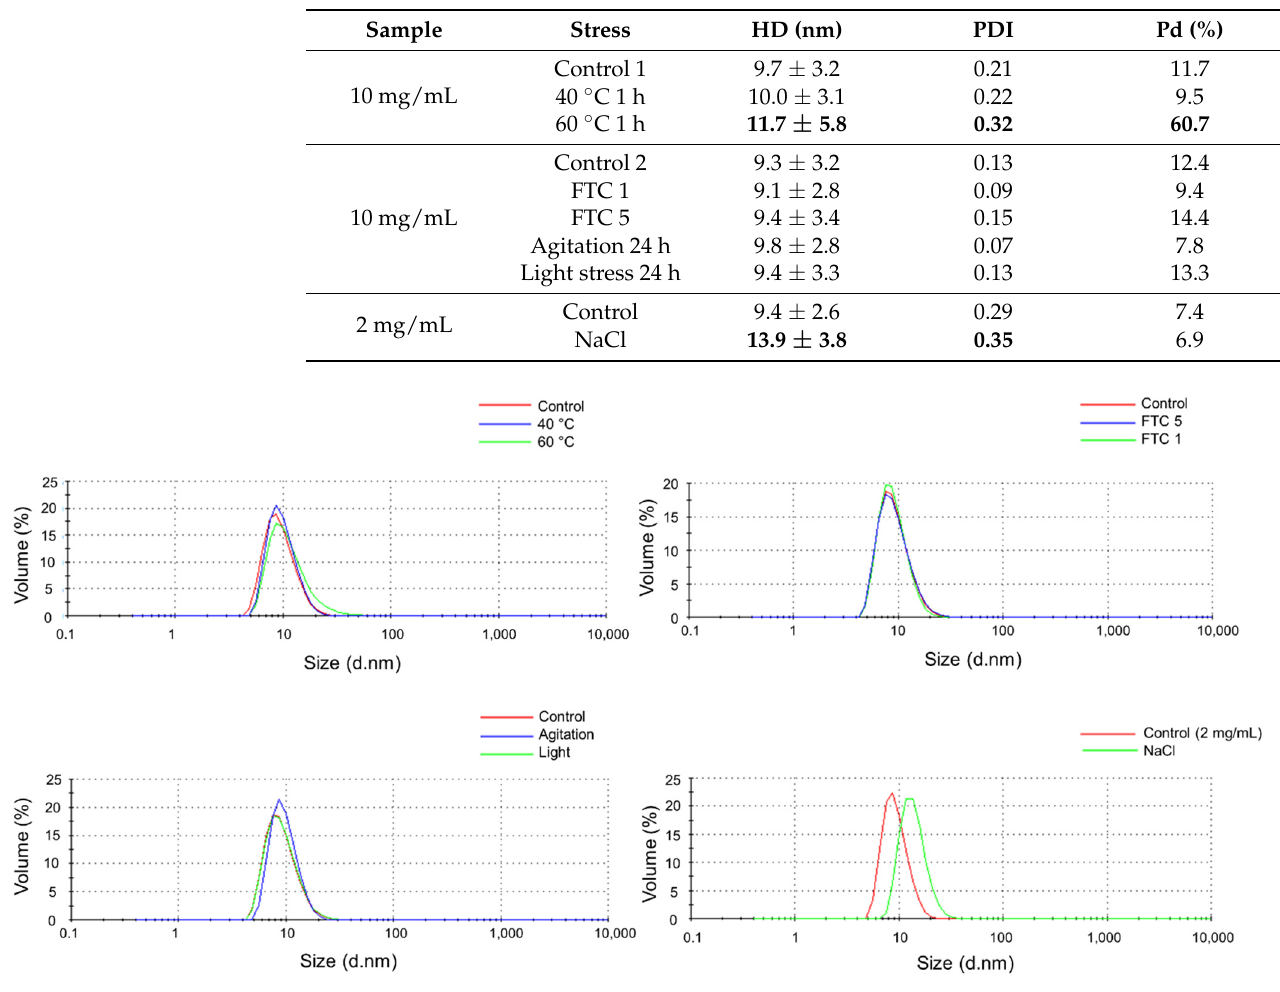
Figure 3. Particulate size distributions by volume in control and stressed samples of nivolumab.